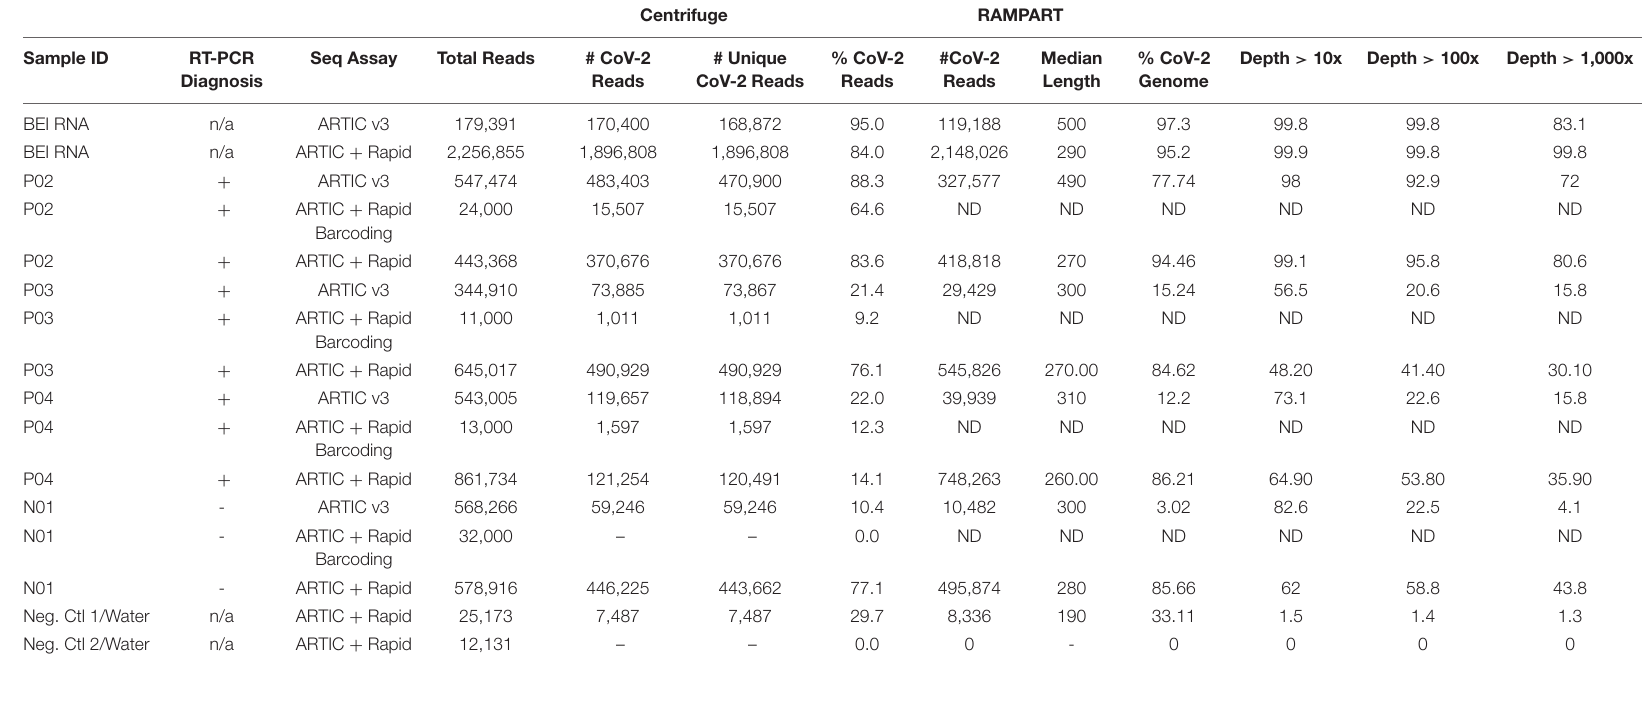
TABLE 2 | Pilot study evaluating ARTIC-based assays for sequencing SARS-CoV-2 from clinical